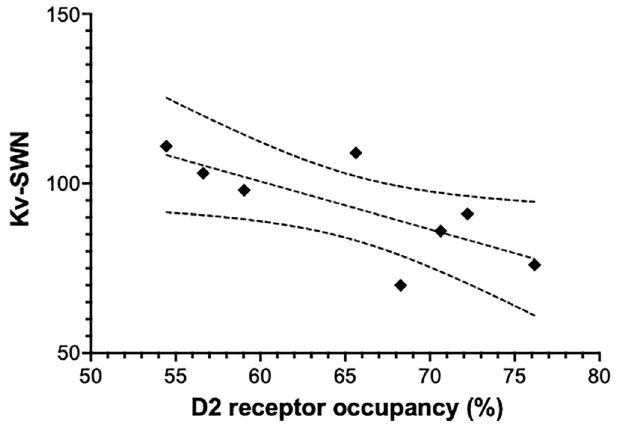
Figure 1. The relationship between D2 receptor occupancy by aripiprazole and scores of Korean version of subjective well-being under Neuroleptics Scale-Short form (Kv-SWN) (R 2 = 0.55, p =